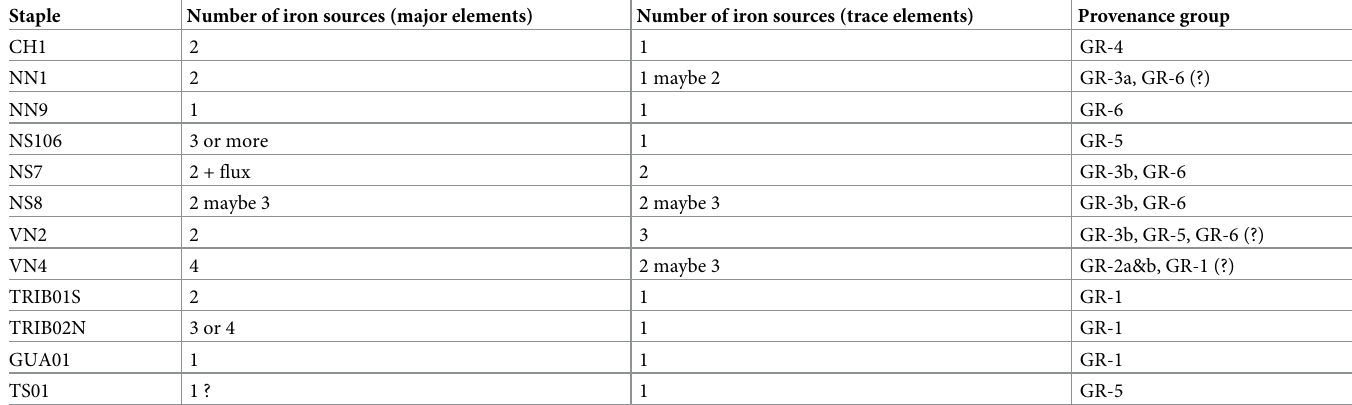
Table 6. Summary of provenance results. “?” means unsure compatibility as very few SI are involved in the group or staples belong to different subgroups (a&b). Staple